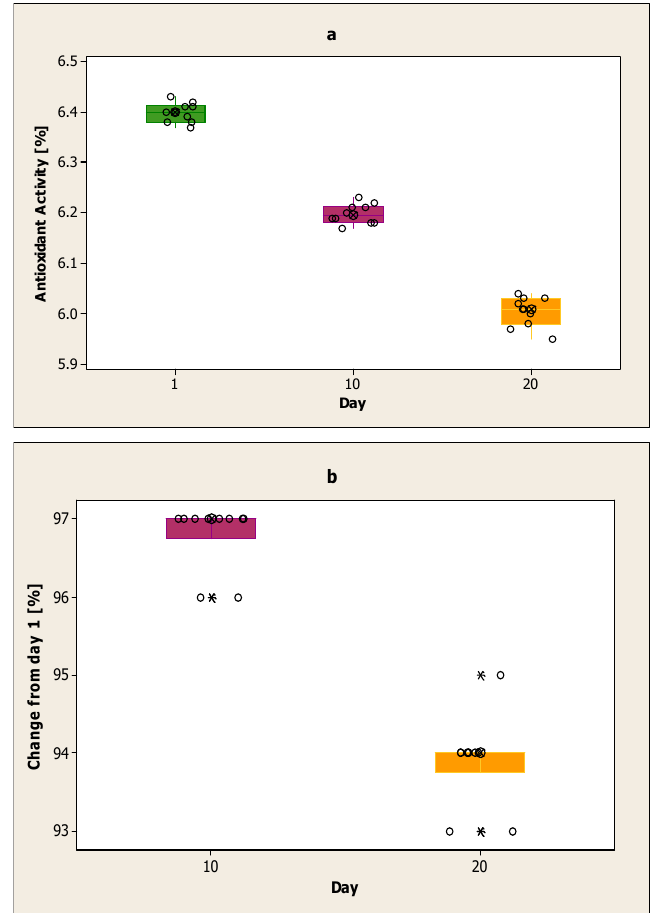
Figure 4. ( a ) Antioxidant activity of the yoghurt sample from cow milk with the addition of volatile